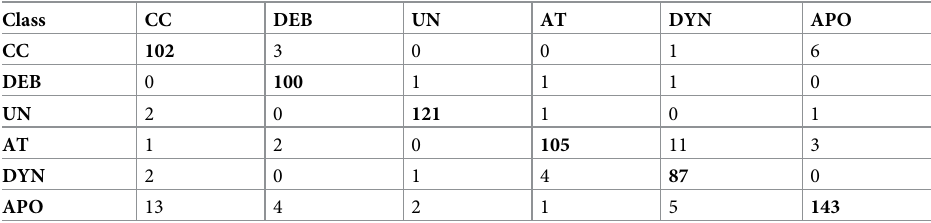
Table 10. Confusion matrix for the classification of the 724 real hESC images using the CNN-Triplet architecture of DeephESC 2.0. Class CC